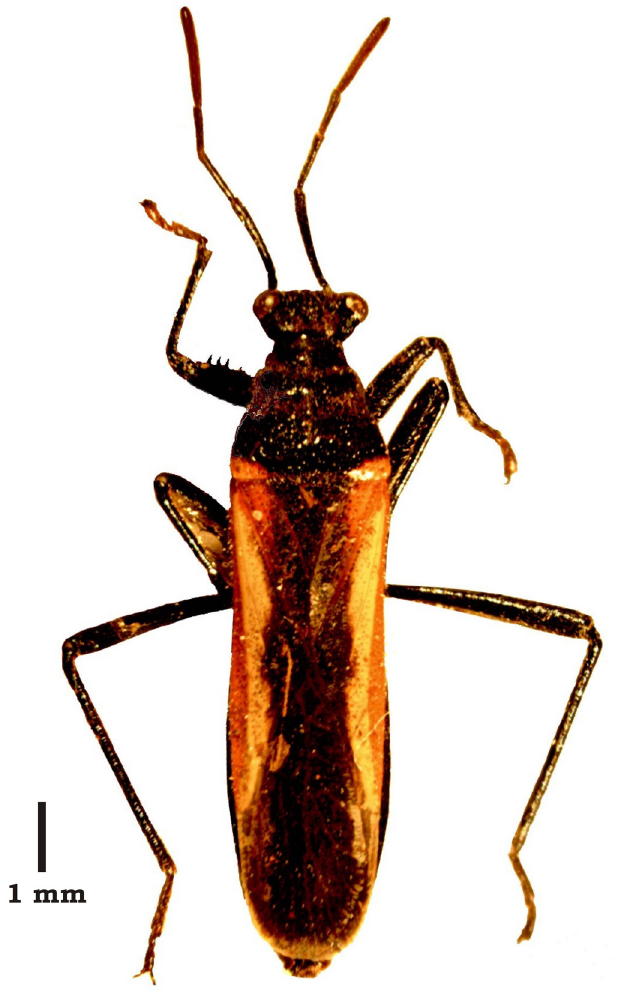
Figure 1. Theraneis vittata